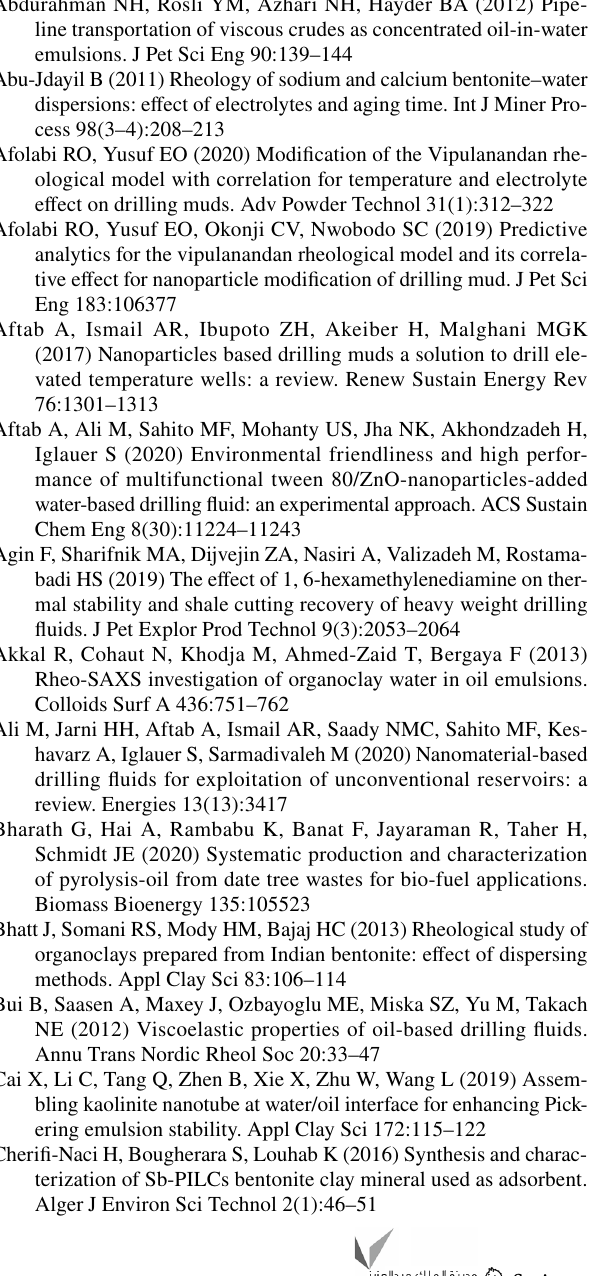
Fig. 10 Thixotropic loop area of gasoil-based drilling muds as func- tion of VG69 organophilic clay